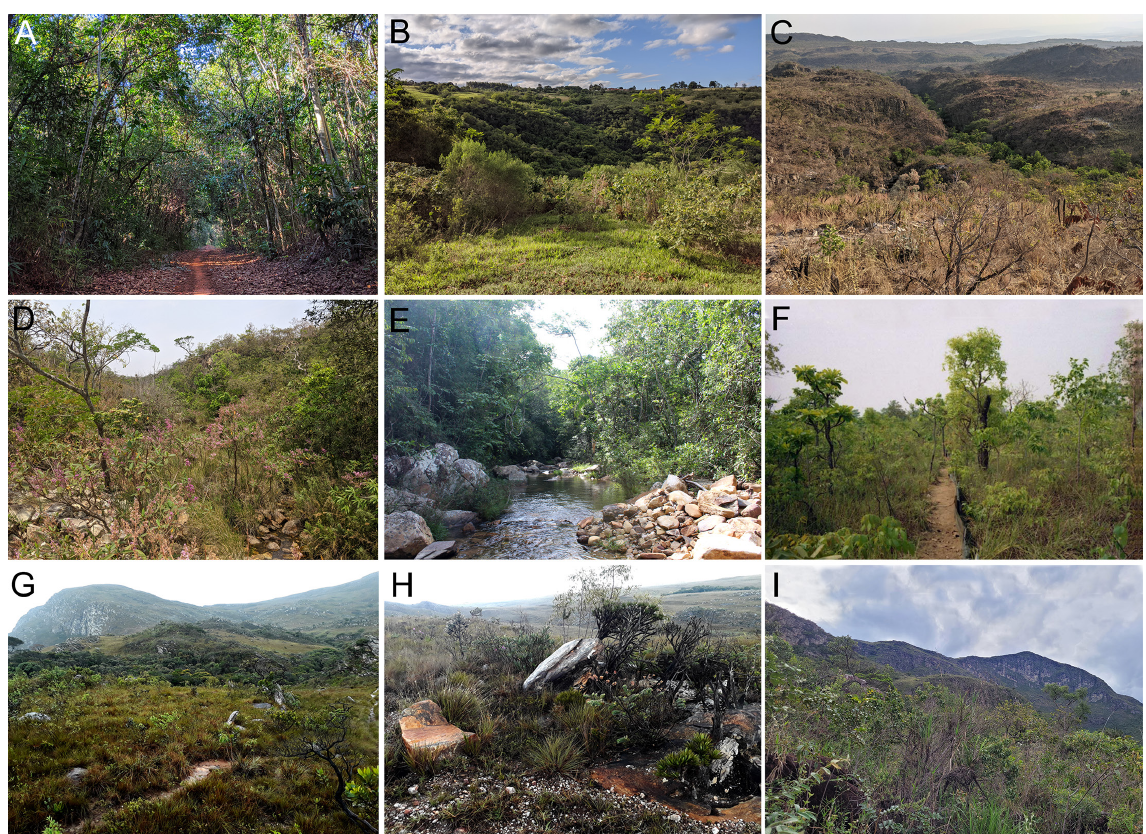
Fig. 53. Habitats of Arumatia Ghirotto gen. nov. in the Cerrado of Brazil. A–D . Habitat of Arumatia dubia gen. et comb. nov., seasonal forest at Assis, São Paulo (A), seasonal forest at Echaporã, São Paulo (B), savannah formation at Delfinópolis, Minas Gerais (C–D). E . Type locality of